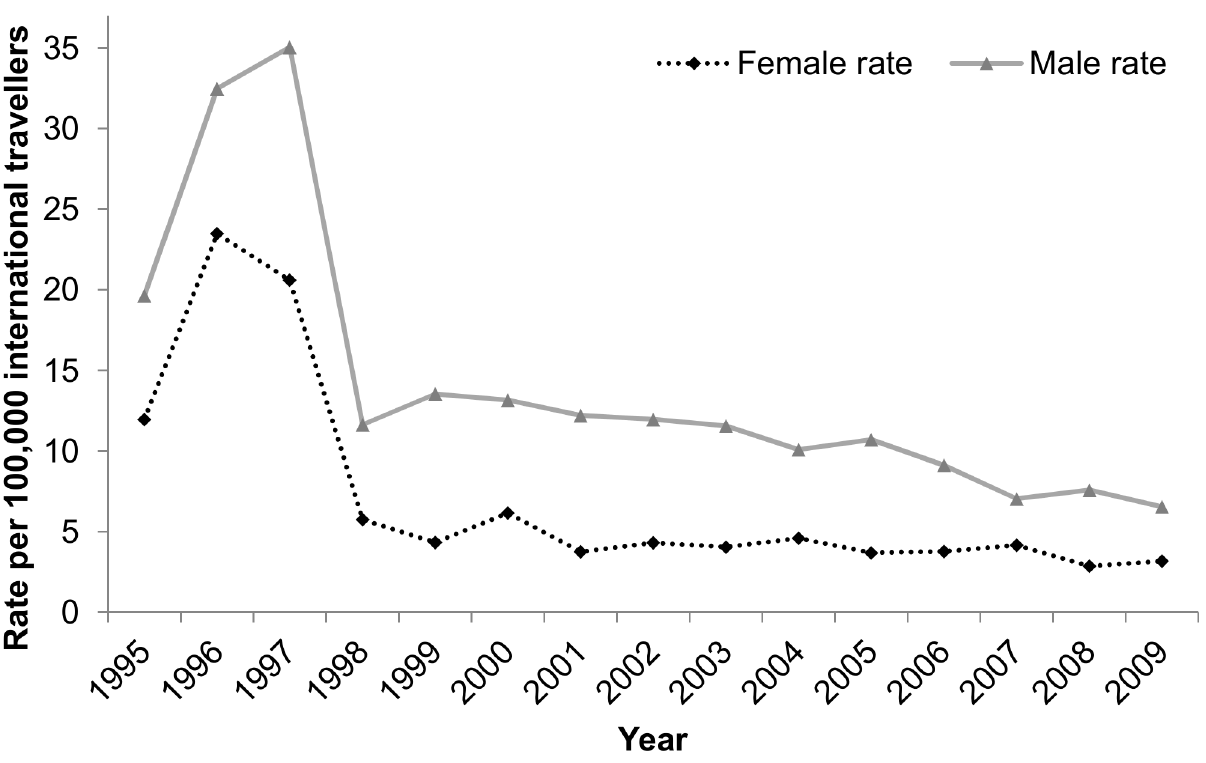
Figure 2. Plasmodium infection rates in male and female travellers for imported malaria cases (all Plasmodium species) in Ontario, Canada (1995–2009) *. *Rate per 100,000 international travellers estimated based on total Canadians returning from travel to international locales (except USA) and returning to Ontario